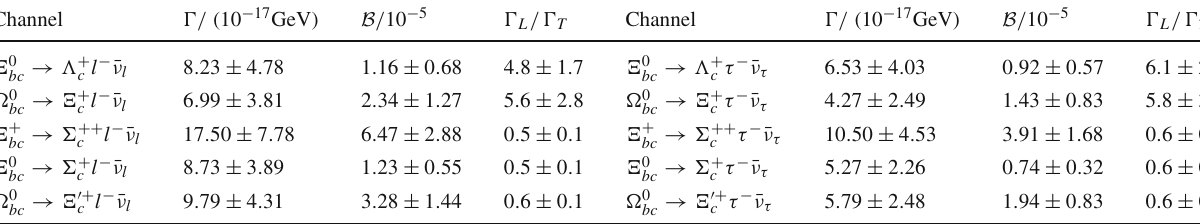
Table 18 Same as Table 15, but for the bottom decay of bottom–charm baryons